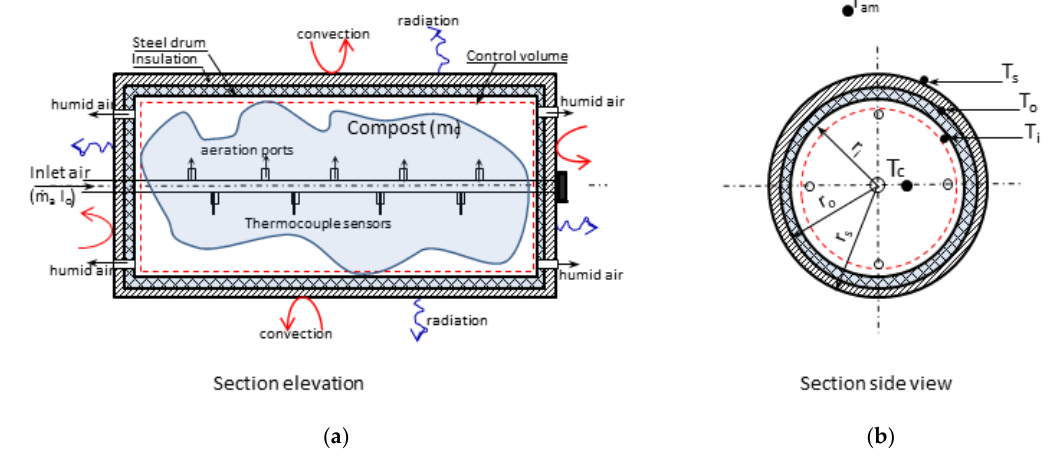
Figure 2. Cross sectional views of the bioreactor showing: ( a ) the air inlet and outlet ports, the horizontal tube including the aeration ports and the thermocouples supports, and the energy terms cross the suggested control volume, and ( b ) thermocouple sensor locations in the bio-reactor.